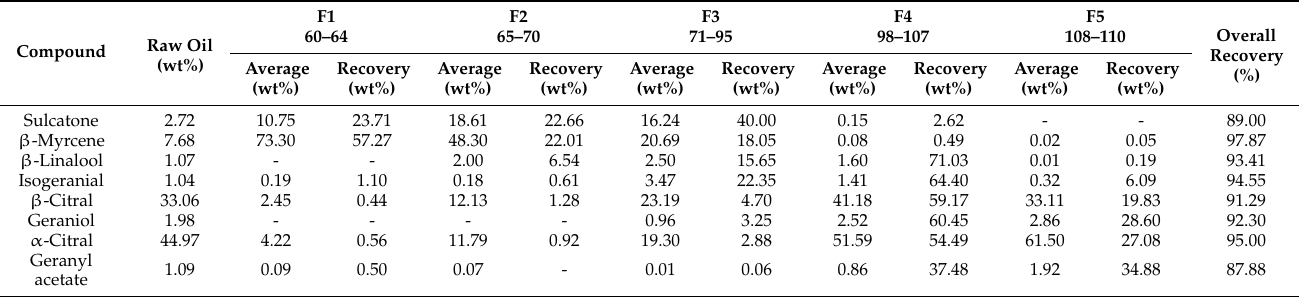
Table 2. Chemical composition and recoveries of the fractions of lemongrass essential